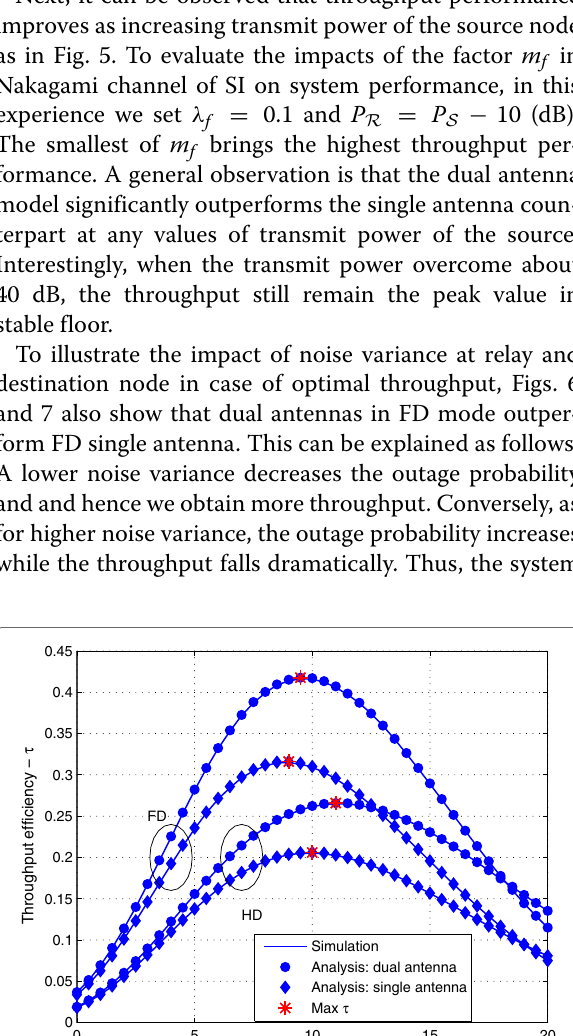
Fig. 5 Throughput efficiency versus P S with difference case of m f , = 0.1 and P R = P S − 10 (dB) λ f